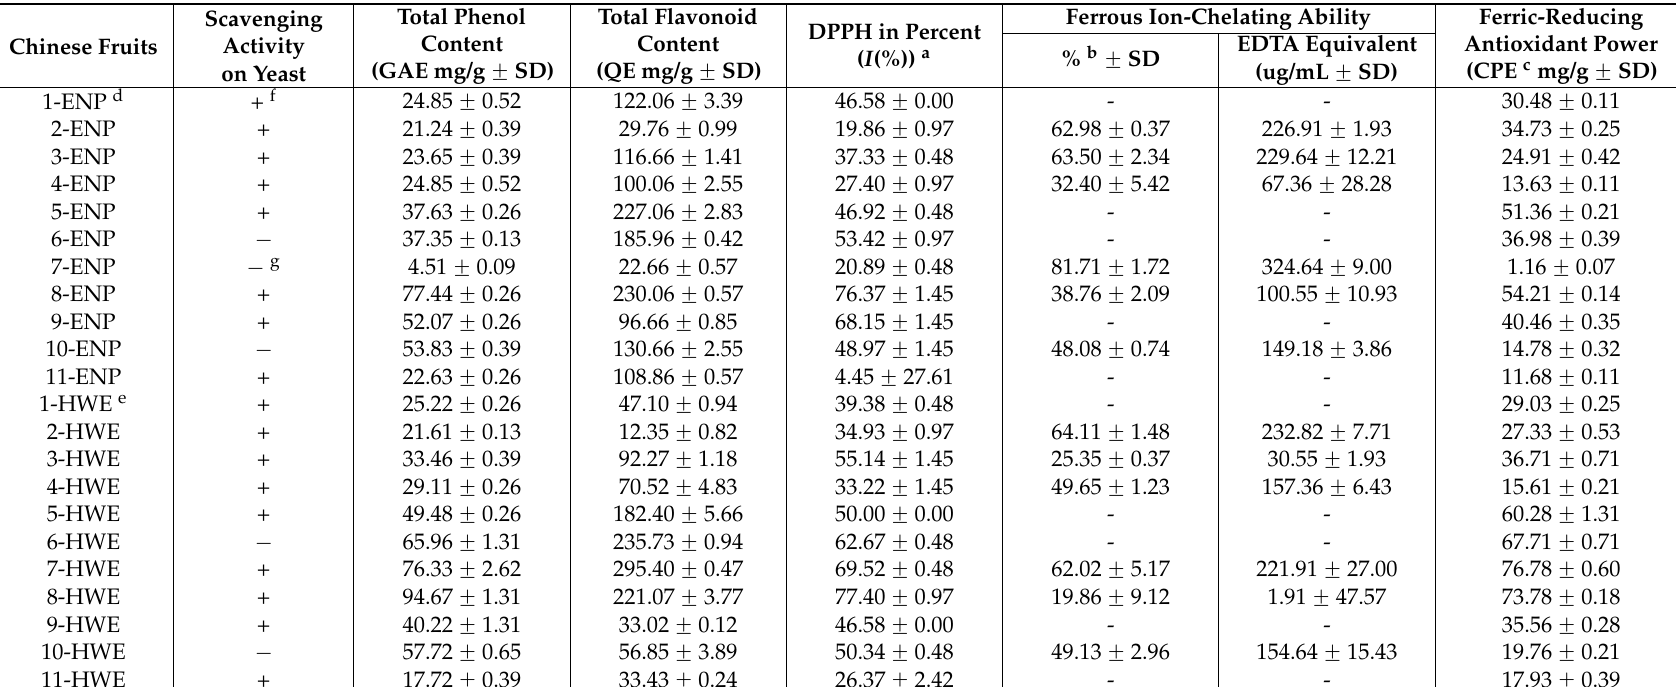
Table 3. Antioxidant activities of endopolysaccharides (ENPs) and hot water extracts (HWEs) obtained for Chinese fruits studied.